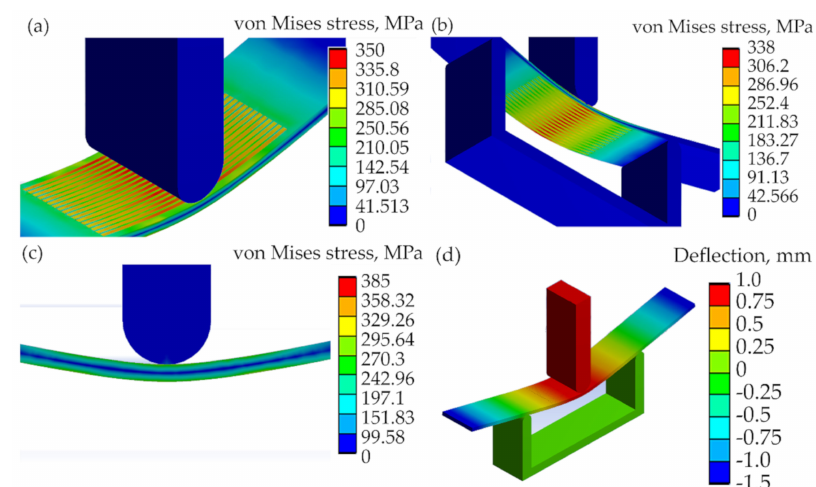
Figure 10. FEA results of the bending modeling of the laser-processed plates when the imposed vertical displacement of the plate middle point B, see Figure 2b, equals 1 mm; von Mises stresses are shown in ( a – c ): ( a ) for case IIIA, ( b ) for case IVB and ( c ) for case IIC; while ( d ) shows the deflections or vertical displacements of the plate of case IIIA.